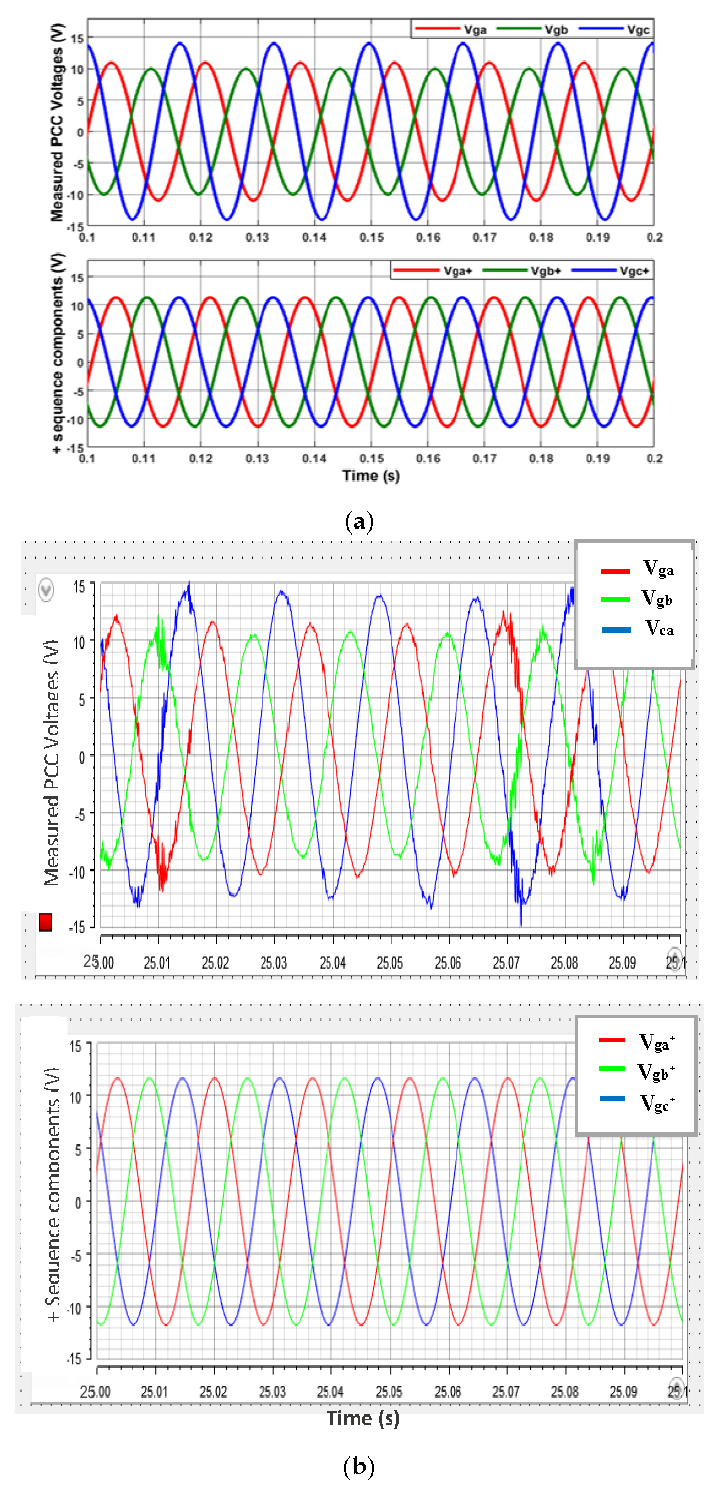
Figure 5. For unbalanced conditions: ( a ) simulation and ( b ) experimental evaluation of the proposed extraction method where measured PCC voltages at the top and the positive sequence components of PCC voltages at the bottom.